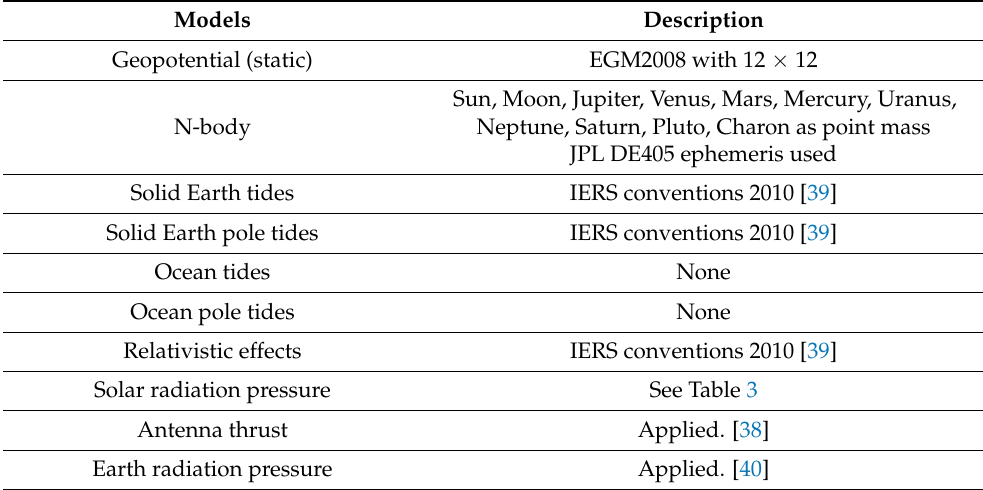
Table 3. Solutions with the SRP model used and estimated parameters.